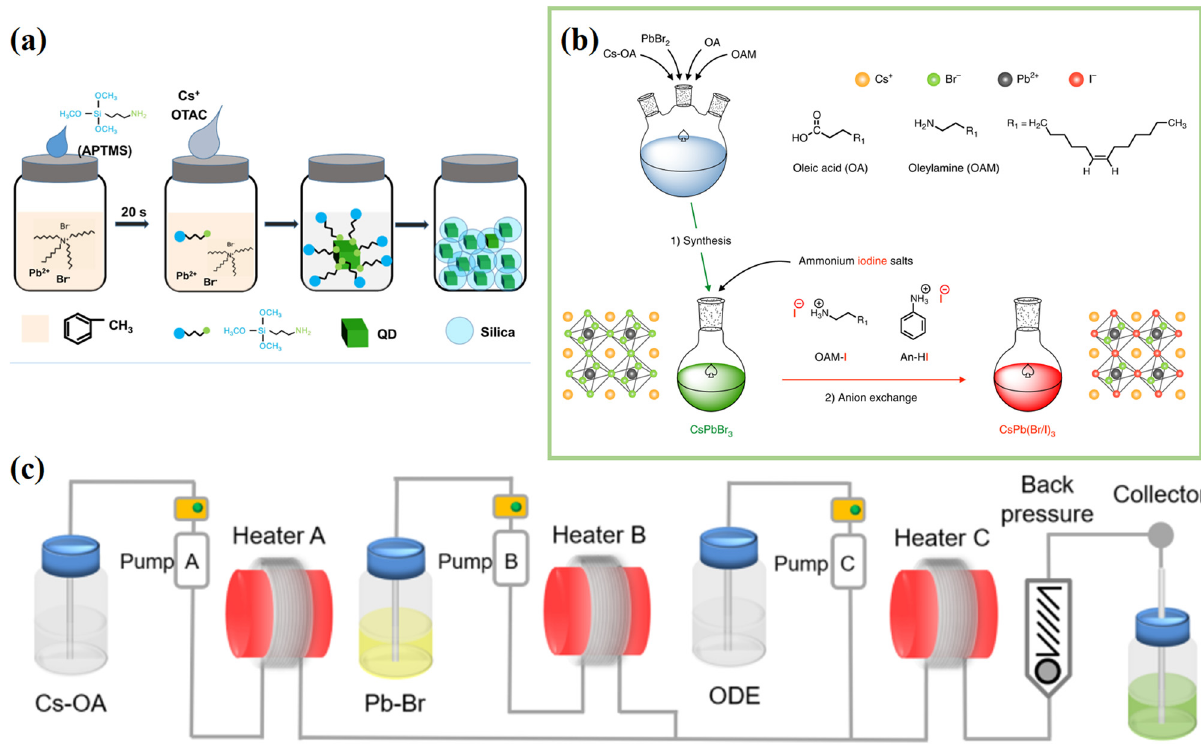
Figure 5: ( a ) Preparation diagram of CsPbBr 3 PQDs solid powder, reproduced with permission from ref. [ 76 ] . Copyright 2021, Elsevier. ( b ) Schematic diagram of anion exchange based on long alkyl ammonium and aryl ammonium, reproduced with permission from ref. [ 79 ] . Copyright 2018, Springer Nature. ( c ) Schematic diagram of the micro fl uidic system for producing CsPbBr 3 /Cs 4 PbBr 6 PNCs, reproduced with permission from ref. [ 81 ] . Copyright 2021,